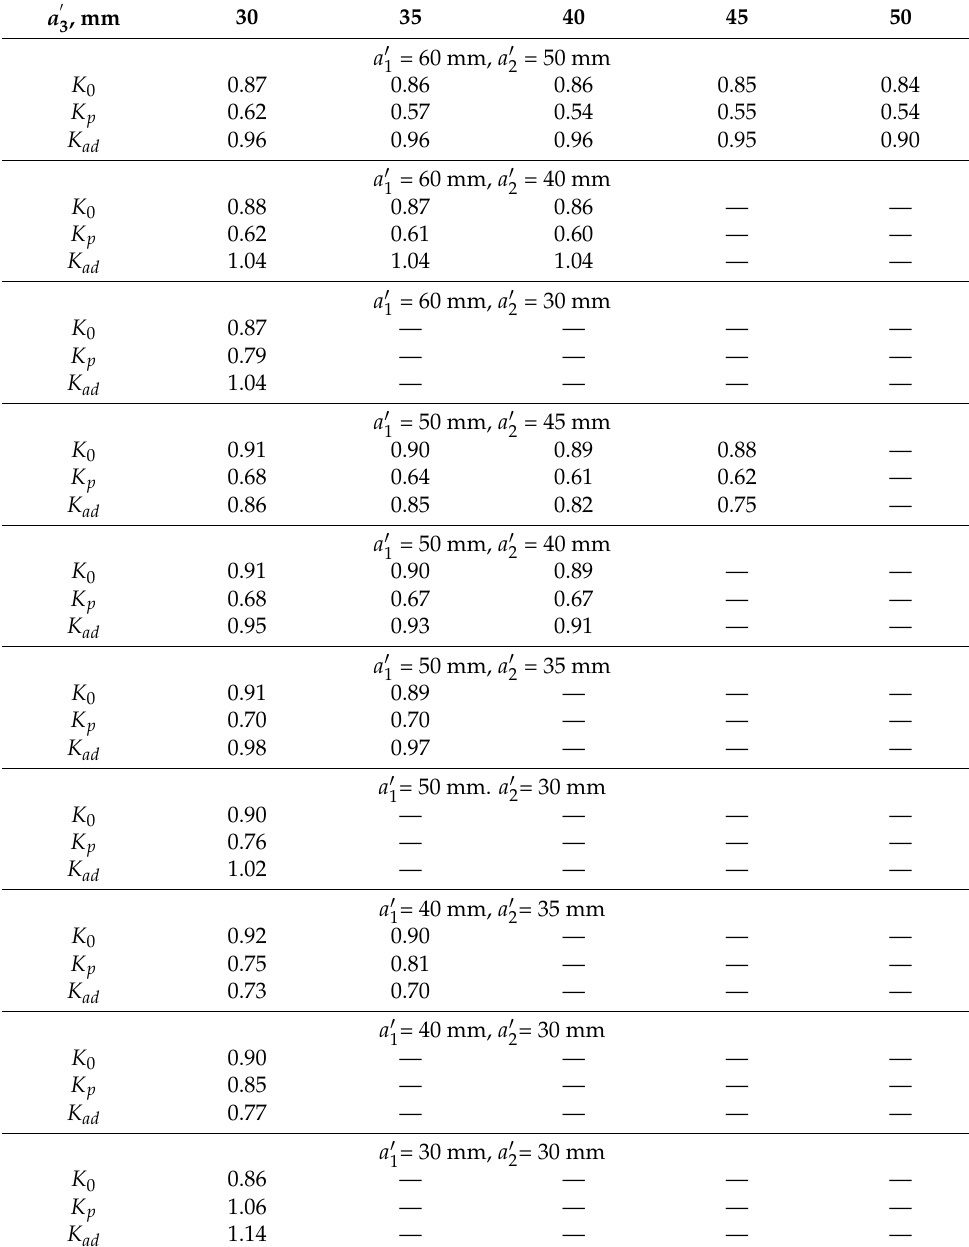
= δ (cid:48) = δ (cid:48) = 0.1 mm. 2 3 1